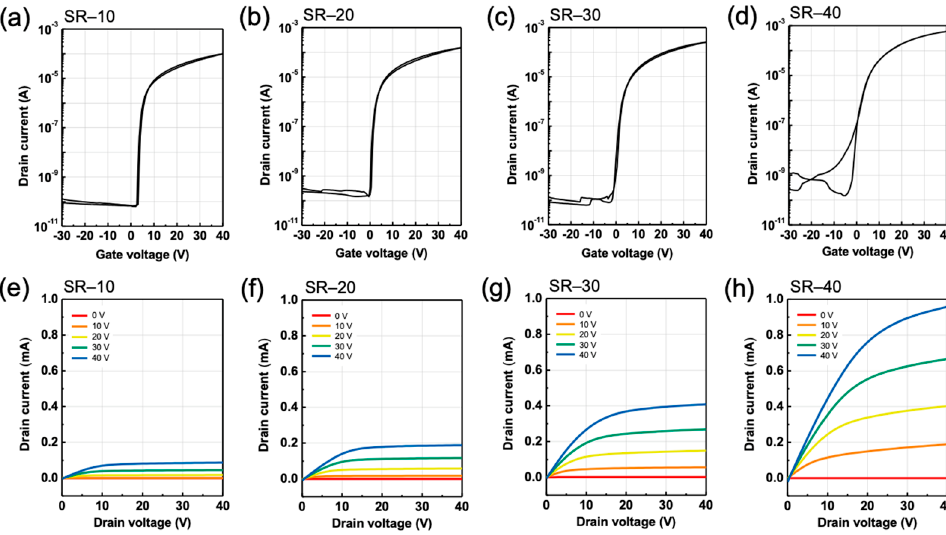
Figure 4. Transfer characteristics of ZTO TFT specimens: ( a ) SR-10, ( b ) SR-20, ( c ) SR-30, and ( d ) SR-40. Output characteristics of ZTO TFT specimens: ( e ) SR-10, ( f ) SR-20, ( g ) SR-30, and ( h ) SR-40.